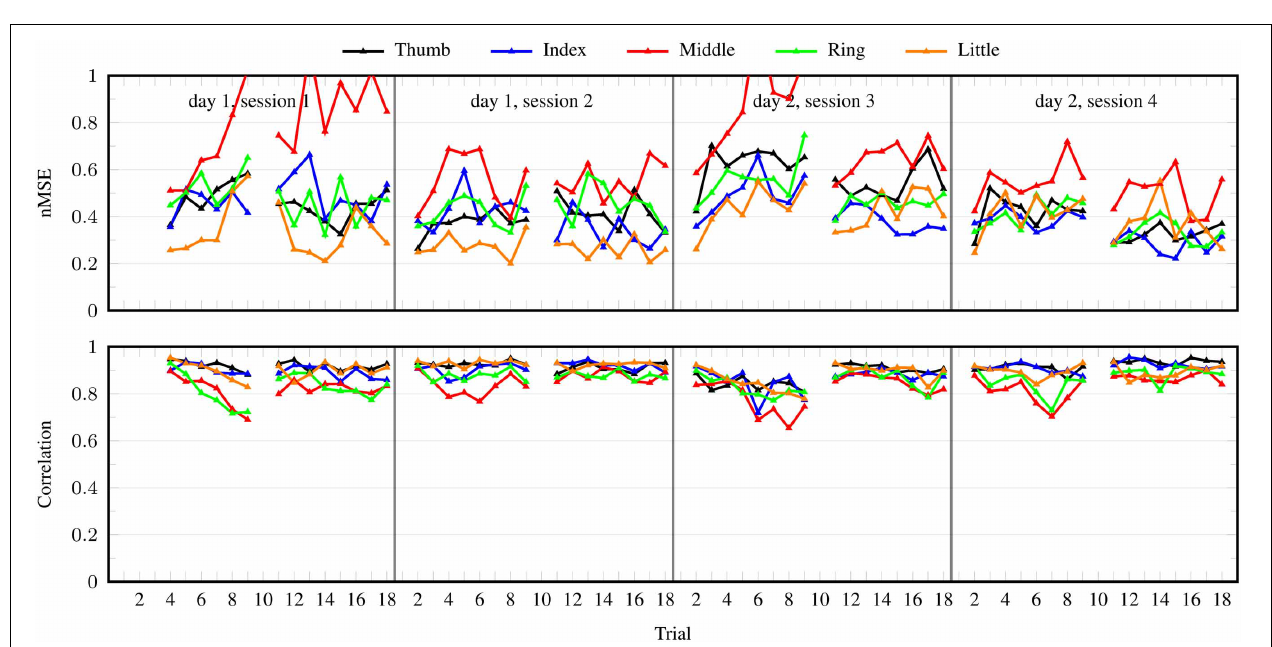
FIGURE 8 | nMSE and correlation coefficient per trial for individual DOFs obtained by iRFFRR 1000 in the realistic setting 2 (training on the binary stimulus). Results averaged over the 10 subjects and over 25 runs with different random initializations.